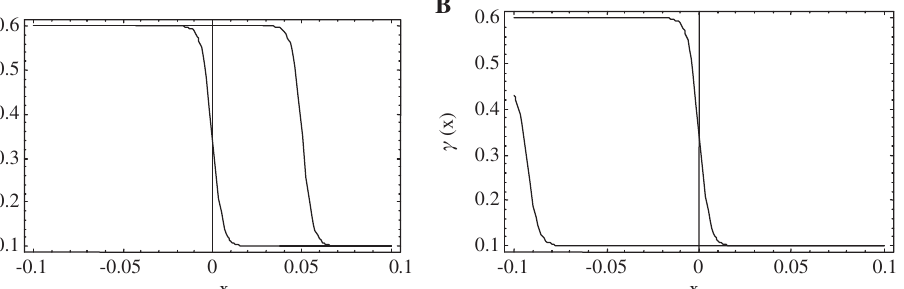
Figure 3 (A) Kink profiles at two different times. The propagation is to the right. (B) Strain nucleus at the edge of the specimen and the kink profile. The maximum value of the strain nucleus is equal to γ ss max